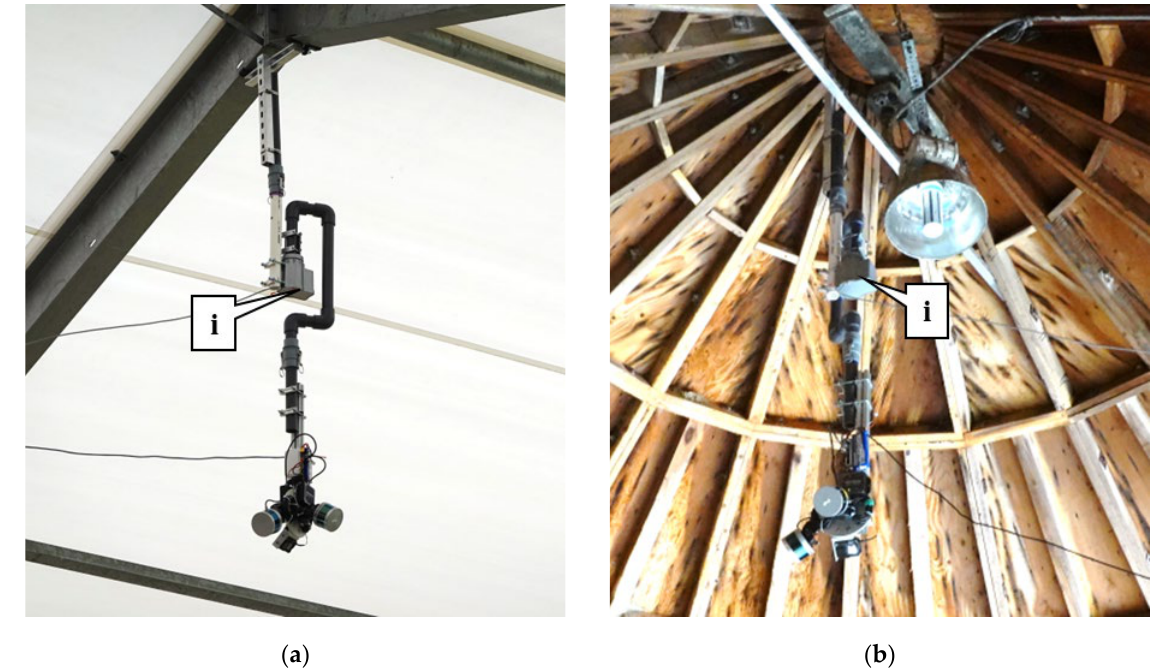
Figure 10. Permanent installation of the SMART system ( a ) Permanent Installation in a Salt Barn ( b ) Permanent Installation in a Salt Dome. ( b ) Permanent Installation in a Salt